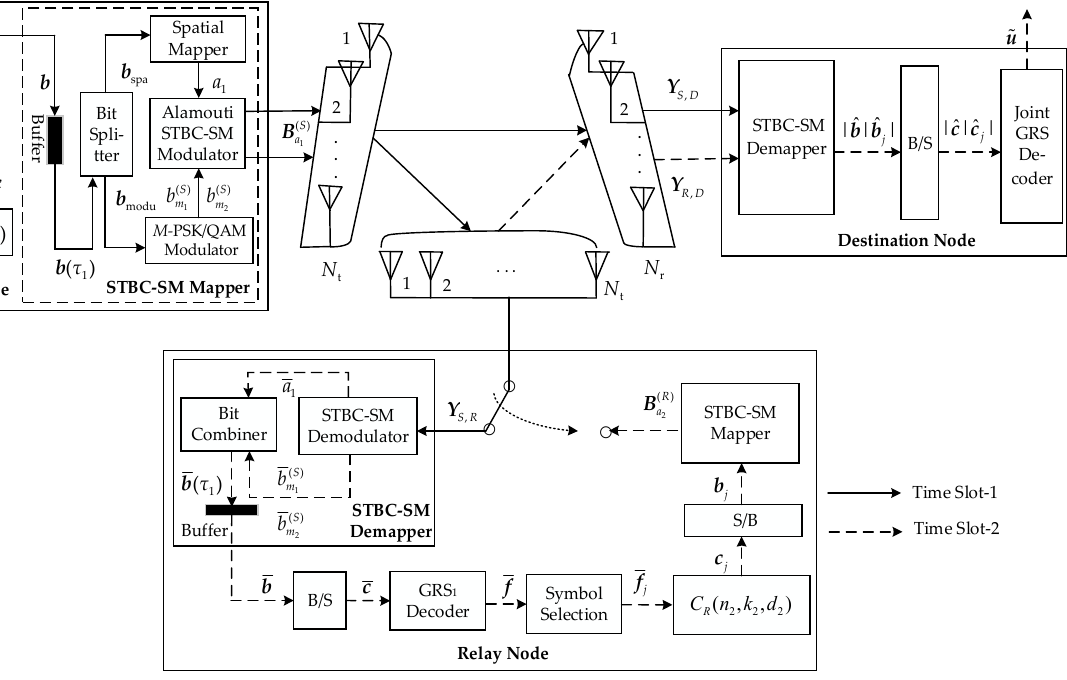
Figure 2. System model of half-duplex DGRSC-STBC-SM scheme. During time slot-1, the source S firstly uses the bits to symbols (B/S) block to convert the binary message bit sequence u into the non-binary symbol sequence f = [ f where f s is an element of the field F q with q = 2 k and k being a positive natural